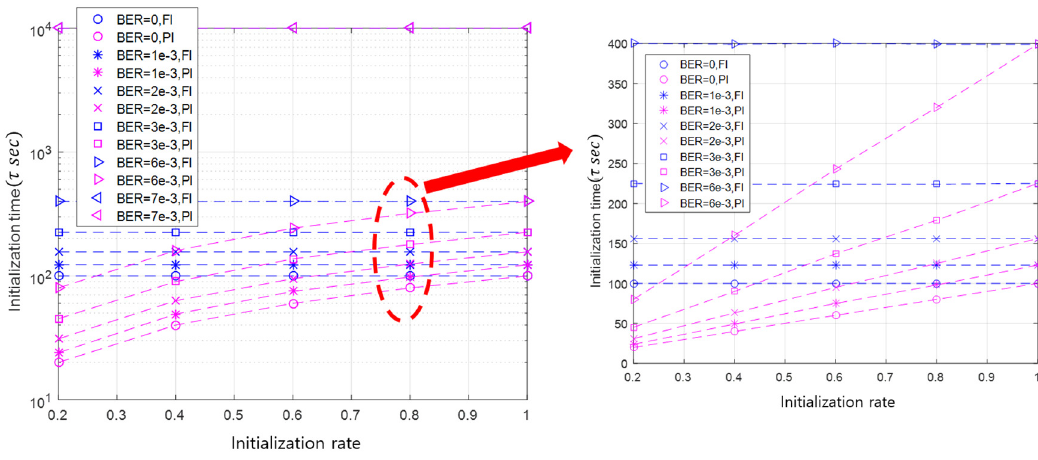
Figure 9. The initialization time of the API and the FI according to BER and the initialization rate.